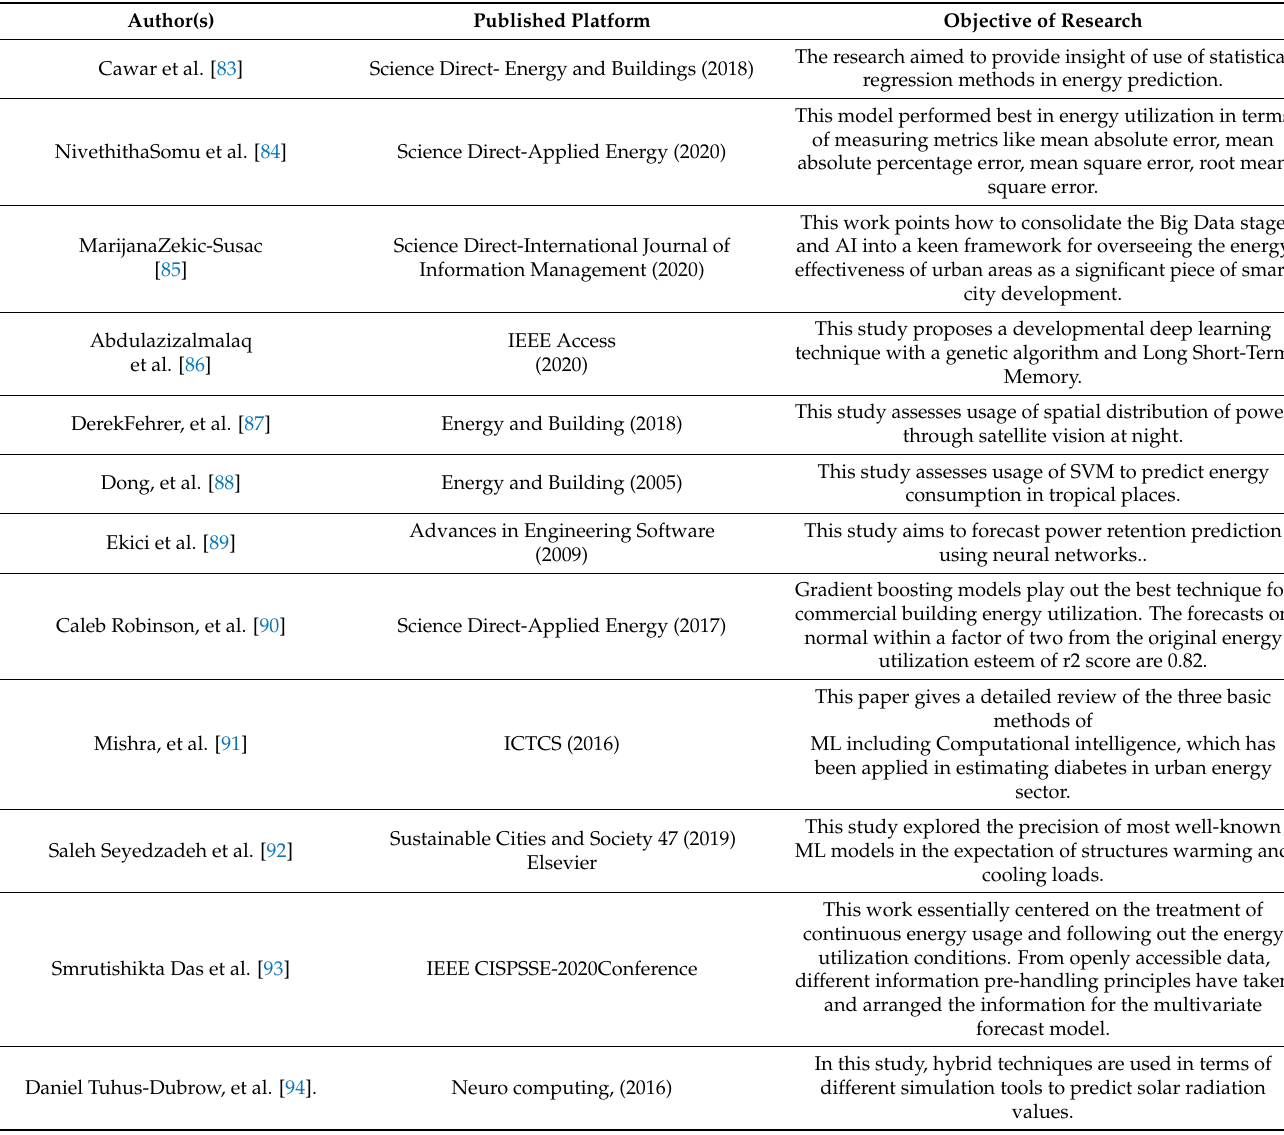
Table 9. Summary of the research